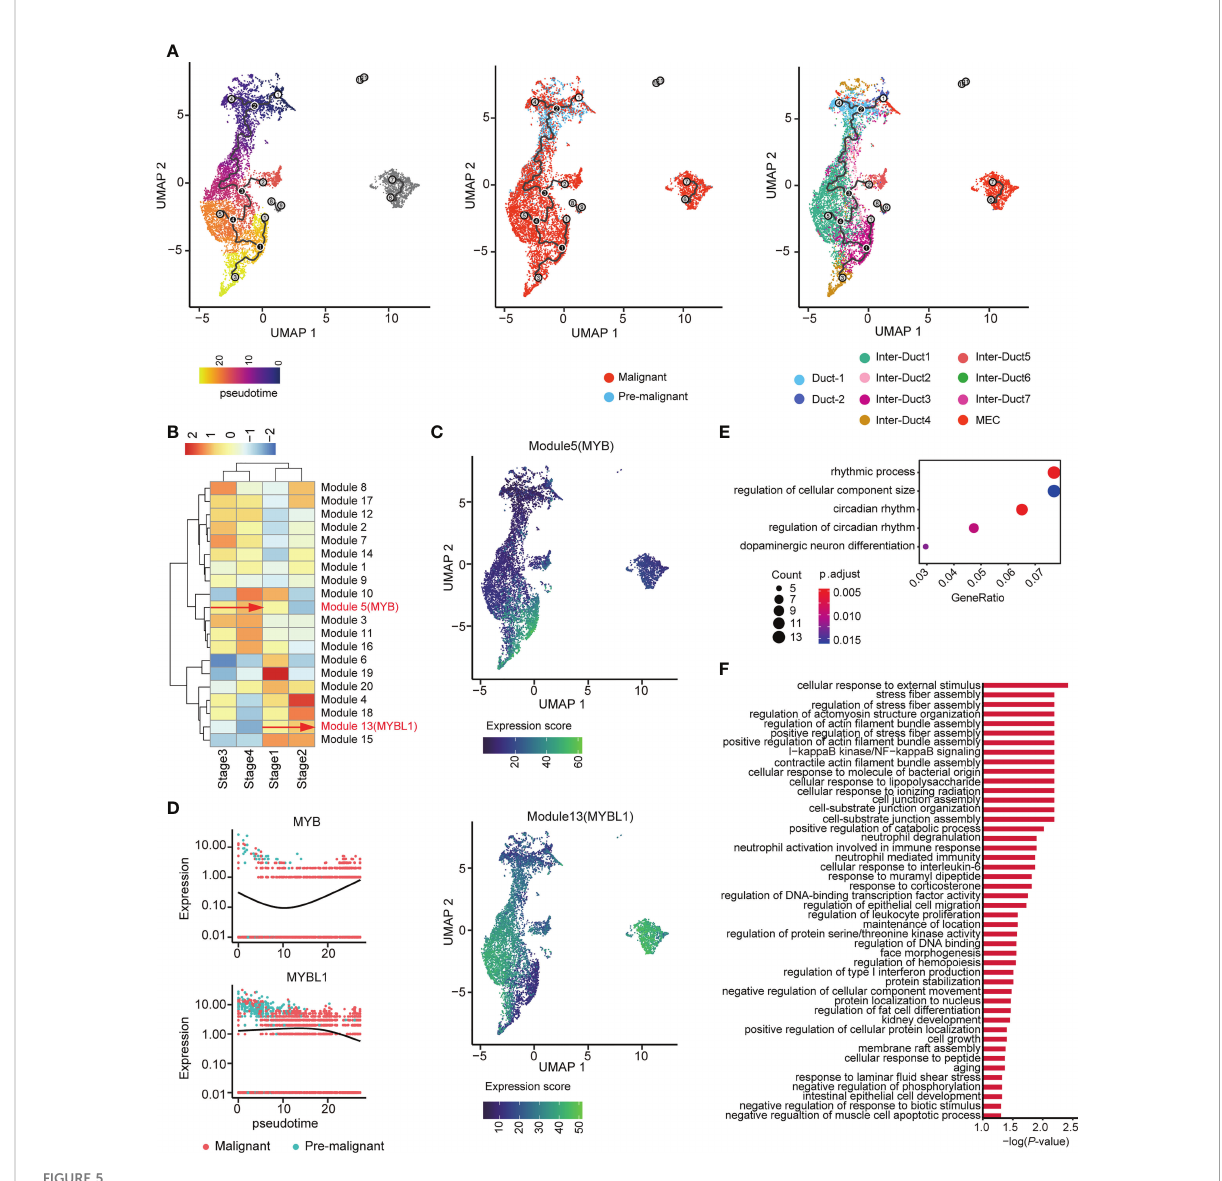
FIGURE 5 Two distinct evolutionary directions of ACC. (A) UMAP visualization of epithelial cells colored by pseudo-time (left), malignant state (middle), and subtype (right). (B) Unsupervised clustering heatmap showing the heterogeneity of gene modules expression over the pseudo-time. MYB and MYBL1 belong to Modules 5 and 13, respectively. (C) UMAP plot shows the gene expression score of Modules 5 (upper) and 13 (lower) among epithelial cells. (D) Dynamics of MYB (upper) and MYBL1 (lower) along pseudo-time. (E) Dot plot showing the results of GO enrichment analysis for genes in Module 5. (F) Bar chart showing the results of GO enrichment analysis for genes in Module